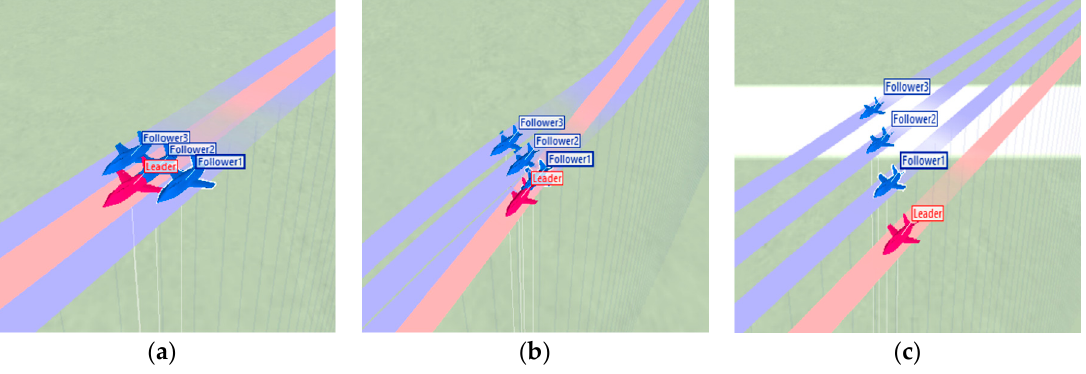
Figure 18. Semi-physical simulation of formation transformation: ( a ) triangular formation; ( b ) intermediate state of formation change; ( c ) ladder formation.